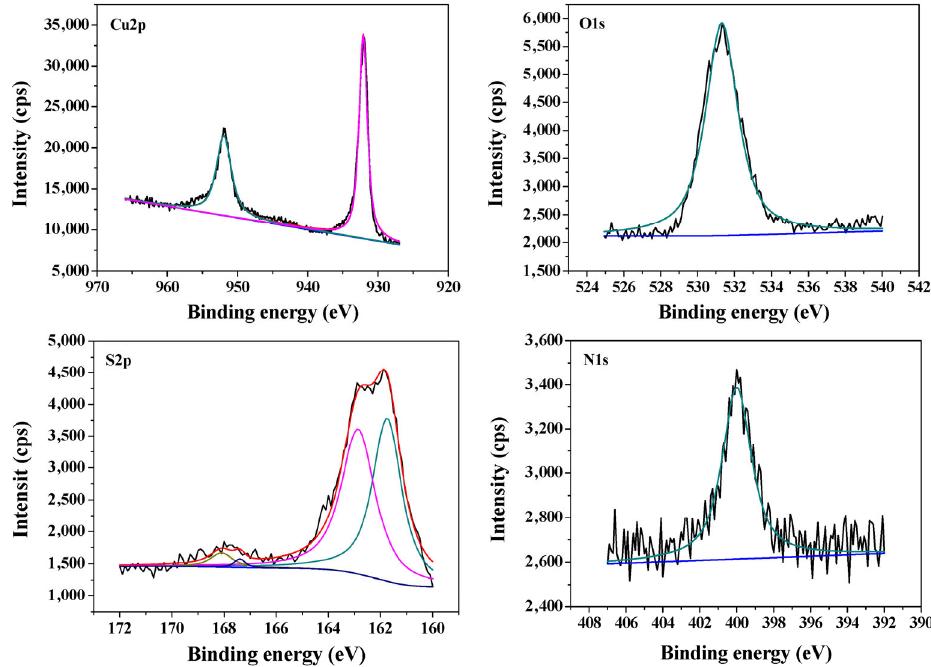
Fig. 4 XPS spectra of Cu2p, O1s, S2p and N1s for water-soluble Cu nanoparticles.